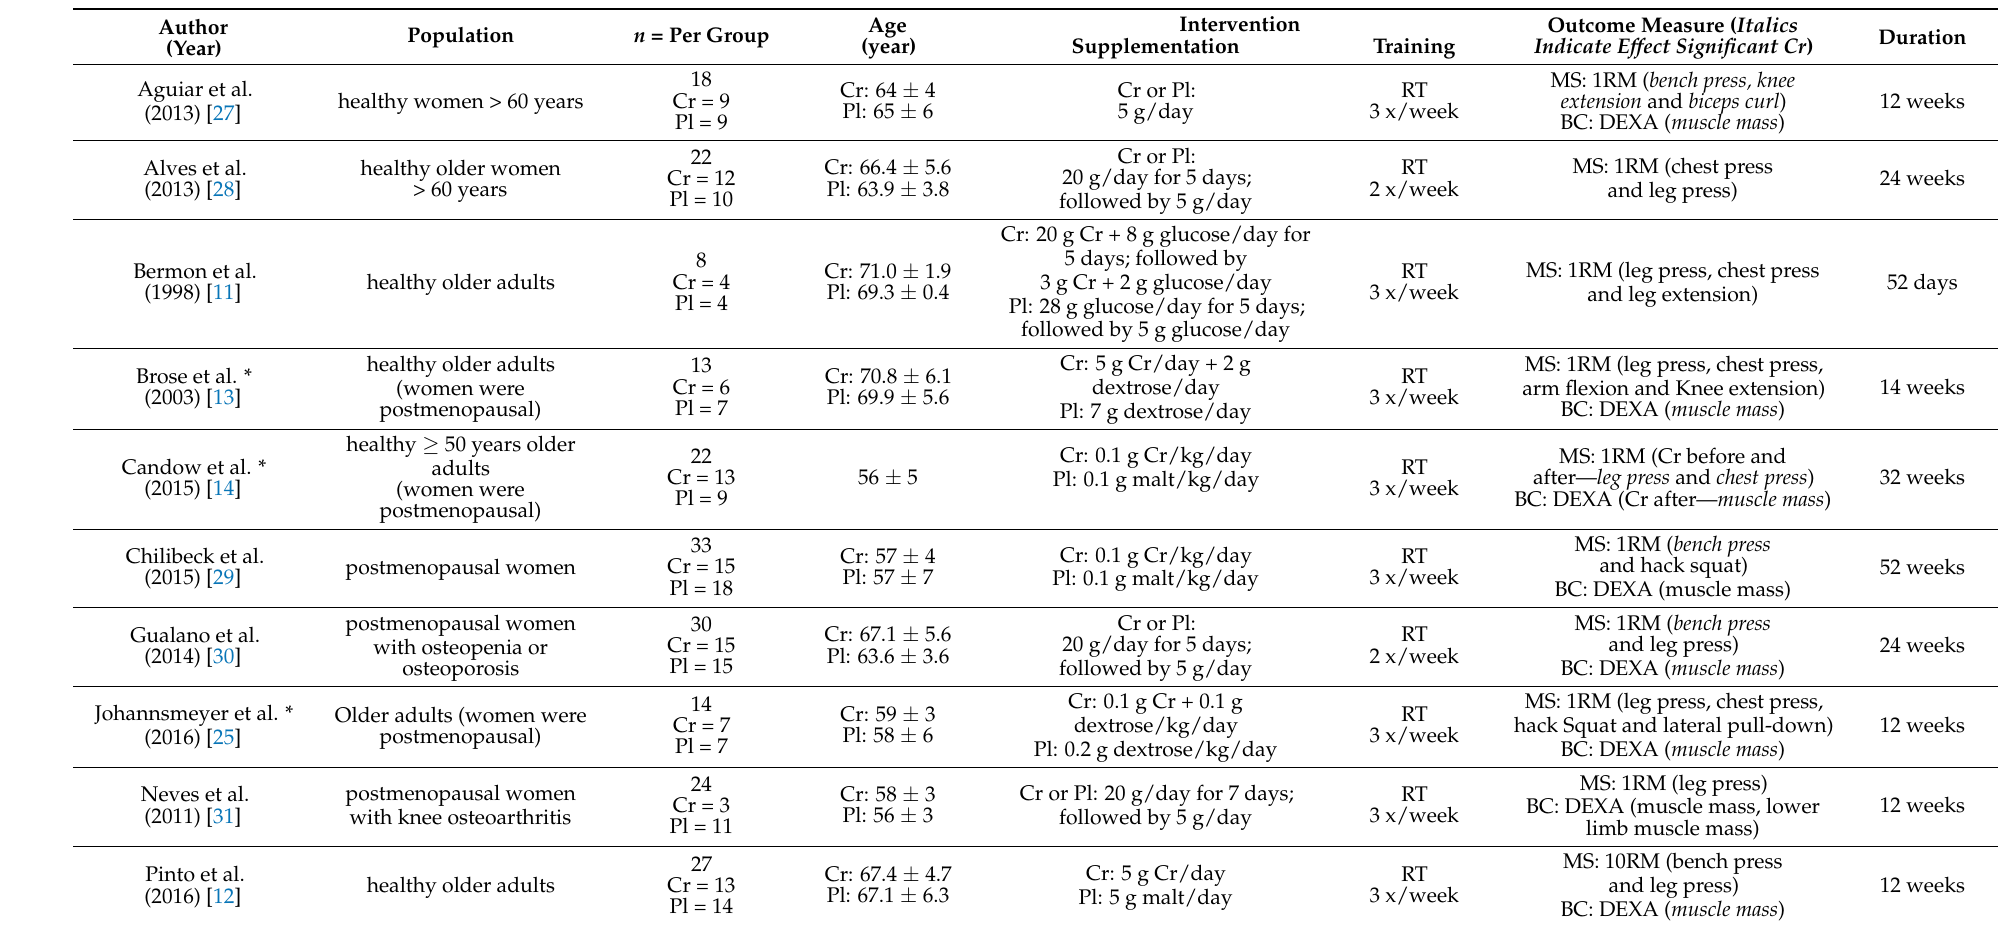
Table 1. Characteristics of Included